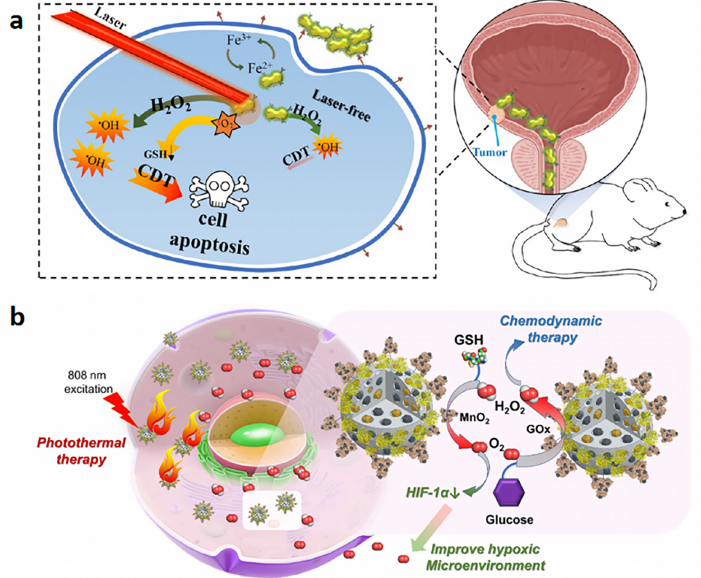
Figure 14. ( a ) Schematic of ROS generation enhanced by CPBA-conjugated Au@Chl/Fe nanorods by the NIR PDT process to subsequently extensively deplete GSH to produce mutual PDT and CDT in bladder cancer therapy. (Reprinted with permission Ref. [129]. Copyright © 2022 American Chemical Society.) ( b ) Schematic of the application of GOx@MBSA-PPy-MnO2 NPs in the GSH- triggered hypoxia relief of bladder cancer and efficient PTT and glucose-triggered CDT. (Reprinted with permission Ref. [124]. Copyright © 2021 American Chemical